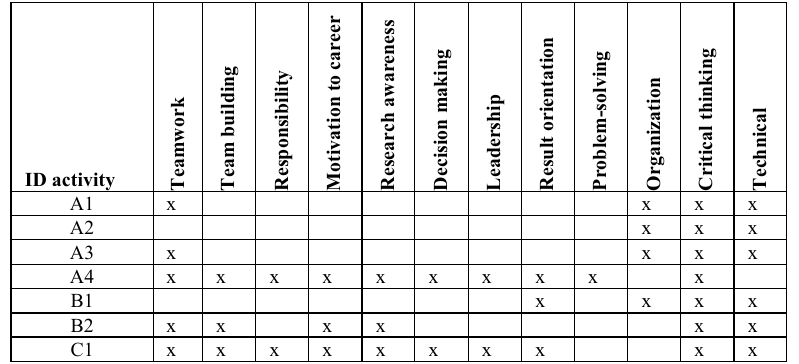
Table 2. Skills assessments activity by